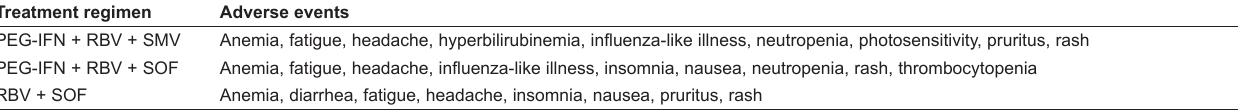
TAble 3 Common adverse events of simeprevir (SMV)- and sofosbuvir (SOF)-based regimens Treatment regimen Adverse